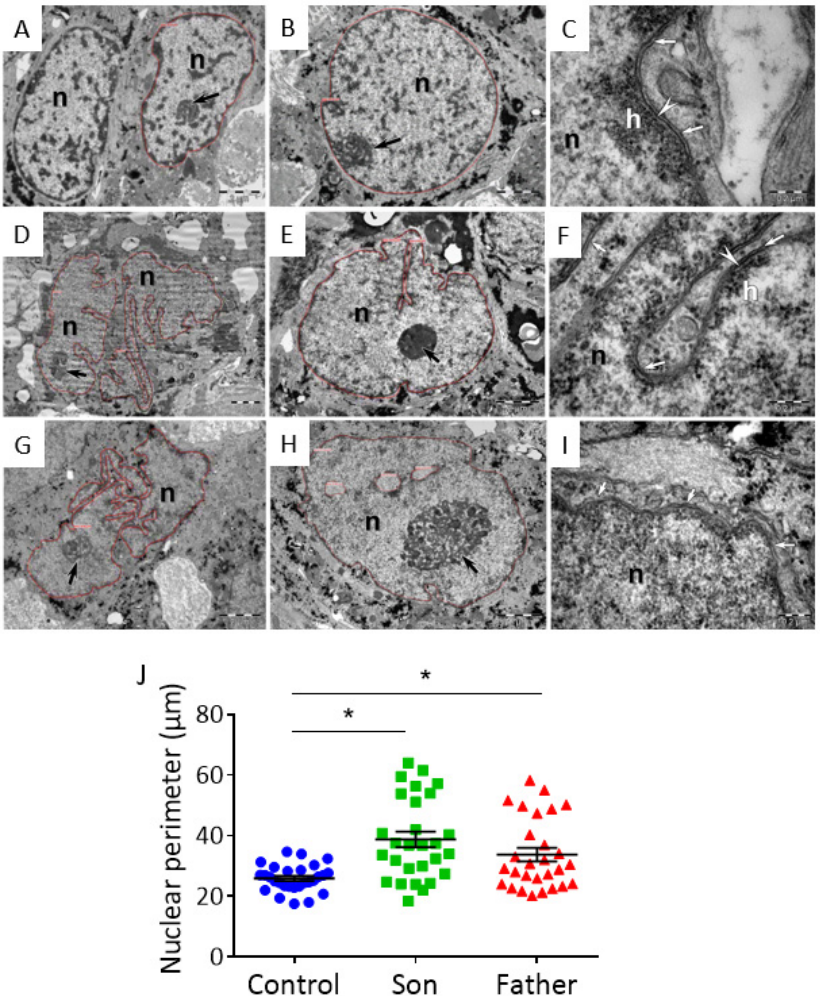
Figure 8. TEM images of LMNA -mutated and control iPSC-CMs. TEM images from control (FSE-5 m) ( A – C ), father ( D – F ) and son ( G – I ) iPSC-CMs. Thin red lines mark nuclear silhouettes. Black arrows point out the nucleoli. ( A , B ) The nuclei (n) of control iPSC-CMs show a smooth contour and scarce heterochromatin, mostly associated with the nuclear envelope (NE). Heterochromatin clumps are also visible inside the nucleus. ( B ) The nucleolus (arrow) with heterogeneous appearance is associated with peripheral heterochromatin. ( C ) Higher magnification shows nuclear lamina (NL) (arrowhead) attaching the heterochromatin (h) to the NE (arrows). ( D , E ) The nuclei (n) of father iPSC-CMs show an irregular contour and indentations. The heterochromatin is limited to the nuclear periphery. ( E ) The nucleolus (arrow) is densely packed. ( F ) Higher magnification shows short segments of NL (arrowhead). The heterochromatin (h) is scarcely attached to the NE (arrows). ( G , H ) The nuclei (n) of son iPSC-CMs show highly indented nuclear contour. ( H ) The heterochromatin is almost absent in the nucleus and the nucleolus (arrow) is large with numerous visible fibrillary centers. ( I ) Higher magnification shows the membranes of the NE (arrows). There is no heterochromatin attached and the lamina is inconspicuous. ( J ) Comparison of nuclear perimeter in control, father and son iPSC-CMs ( n = 29 for each group). One-way ANOVA was performed followed by Holm–Sidak post hoc analysis. * p < 0.05. Scale bar represents: in ( A , B , D , E , G , H )— 2.0 µ m, in ( C , F , I )—0.2 µ